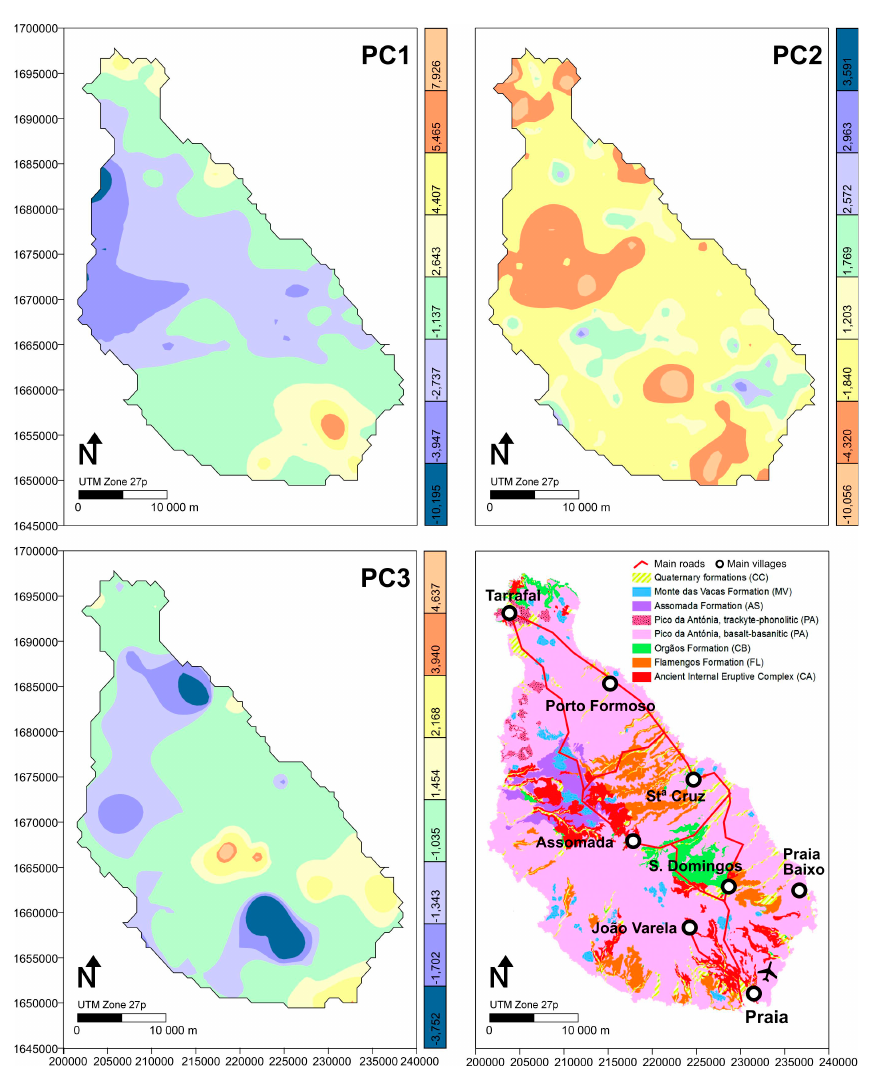
Figure 3. Spatial distribution of PC1 and PC2. The geological map of Figure 1 is shown in the last panel for easier comparison with the PC spatial